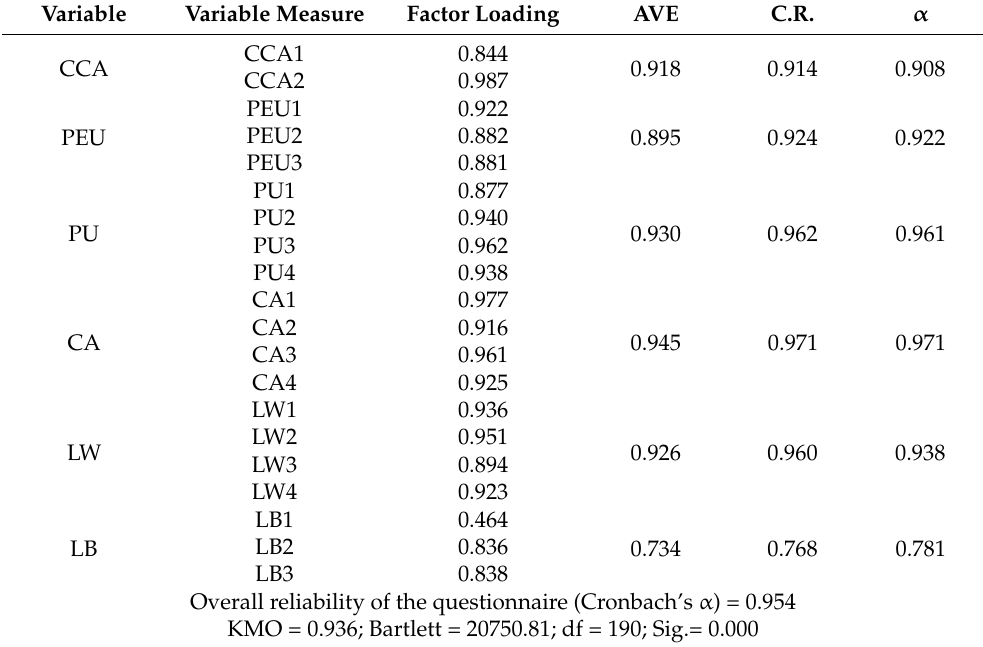
Table 3. Reliability and validity test of